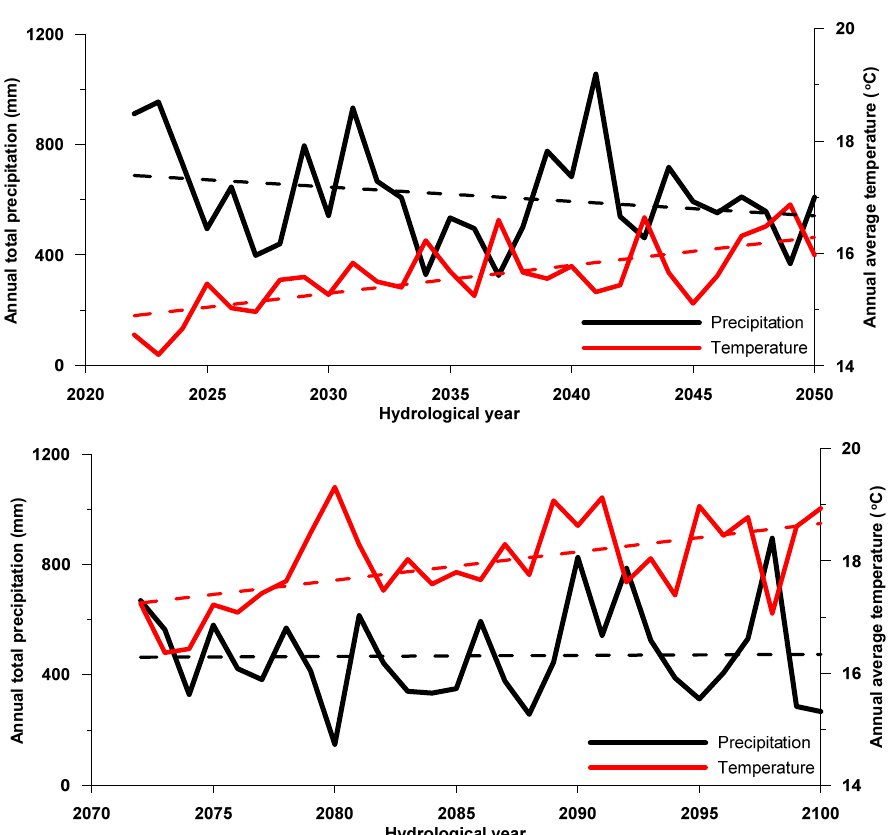
Figure 6. Time series of total annual precipitation (mm) and average annual temperature for the two projected periods, under the adopted RCM.